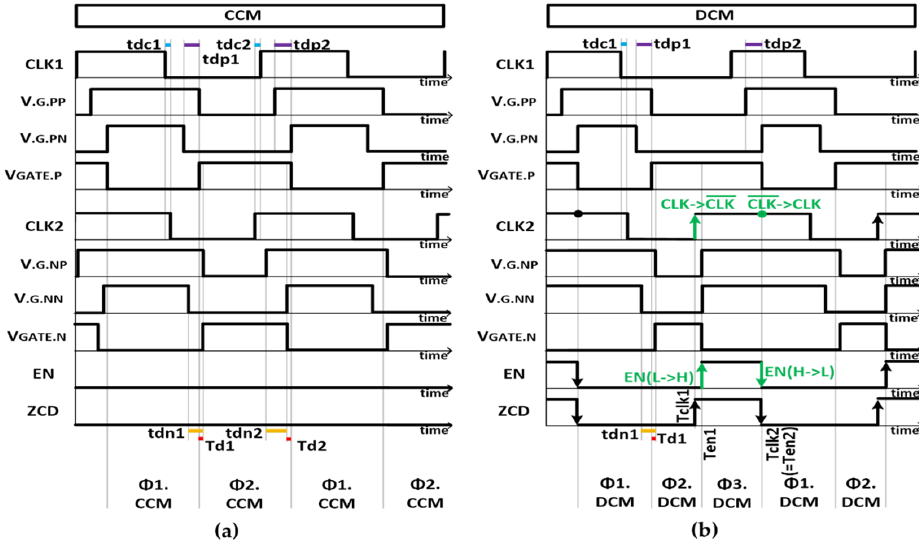
Figure 9. Timing diagrams of the proposed gate driver under ( a ) CCM condition and ( b ) DCM condition.